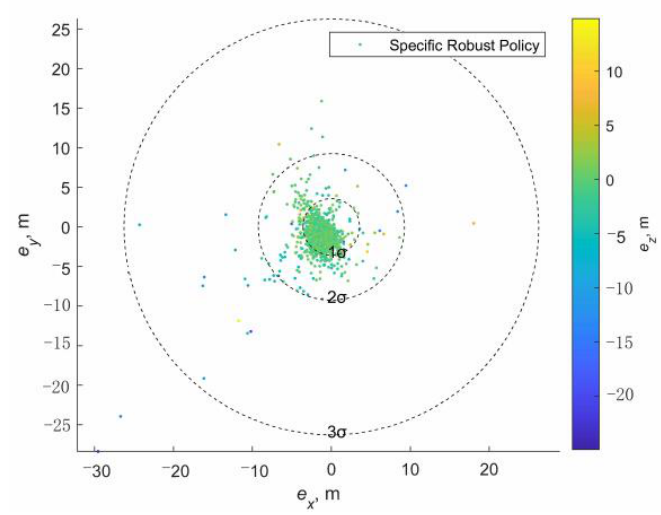
Figure 16. Distribution of the terminal position errors with robust guidance and the SaG strategy.